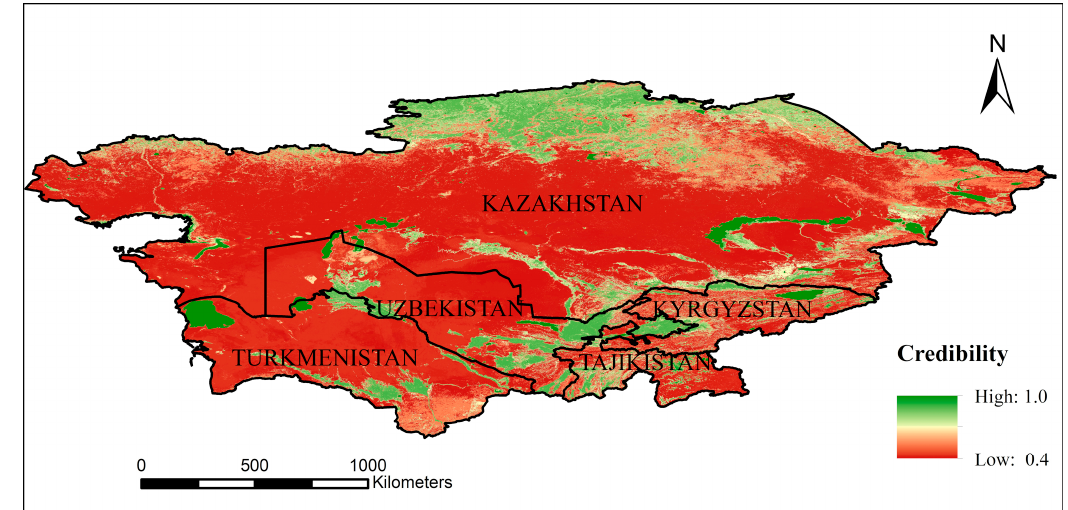
Figure 4. Improved Dempster–Shafer evidence theory: the distribution of credibility ε .